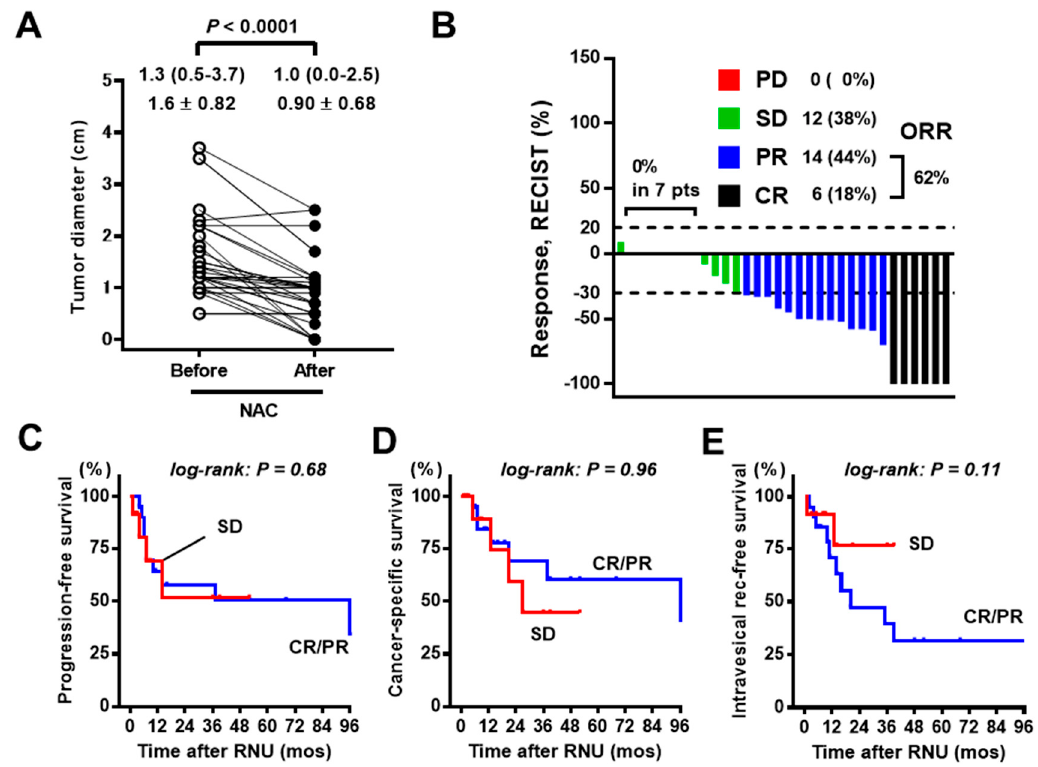
Figure 5. Association between tumor response to NAC by RECIST criteria and the outcomes. ( A ) Dot graphs showing the tumor diameter before and after NAC. Values are shown as median (interquartile range) and mean ± standard deviation. The change was evaluated using the Wilcoxon signed-rank test. ( B ) A waterfall plot depicting tumor response to NAC in 32 patients with ureteral carcinoma. CR = complete response (100% remission), PR = partial response ( ≥ 30% remission), SD = stable disease ( < 30% remission to > 20% increase), PD = progressive disease ≥ 20% increase), ORR = objective response rate (CR or PR). Curves for progression-free survival ( C ), cancer-specific survival ( D ), and intravesical recurrence-free survival ( E ) are plotted and compared according to the tumor response to NAC (CR / PR vs. SD). NAC = neoadjuvant chemotherapy, RNU = radical nephroureterectomy.